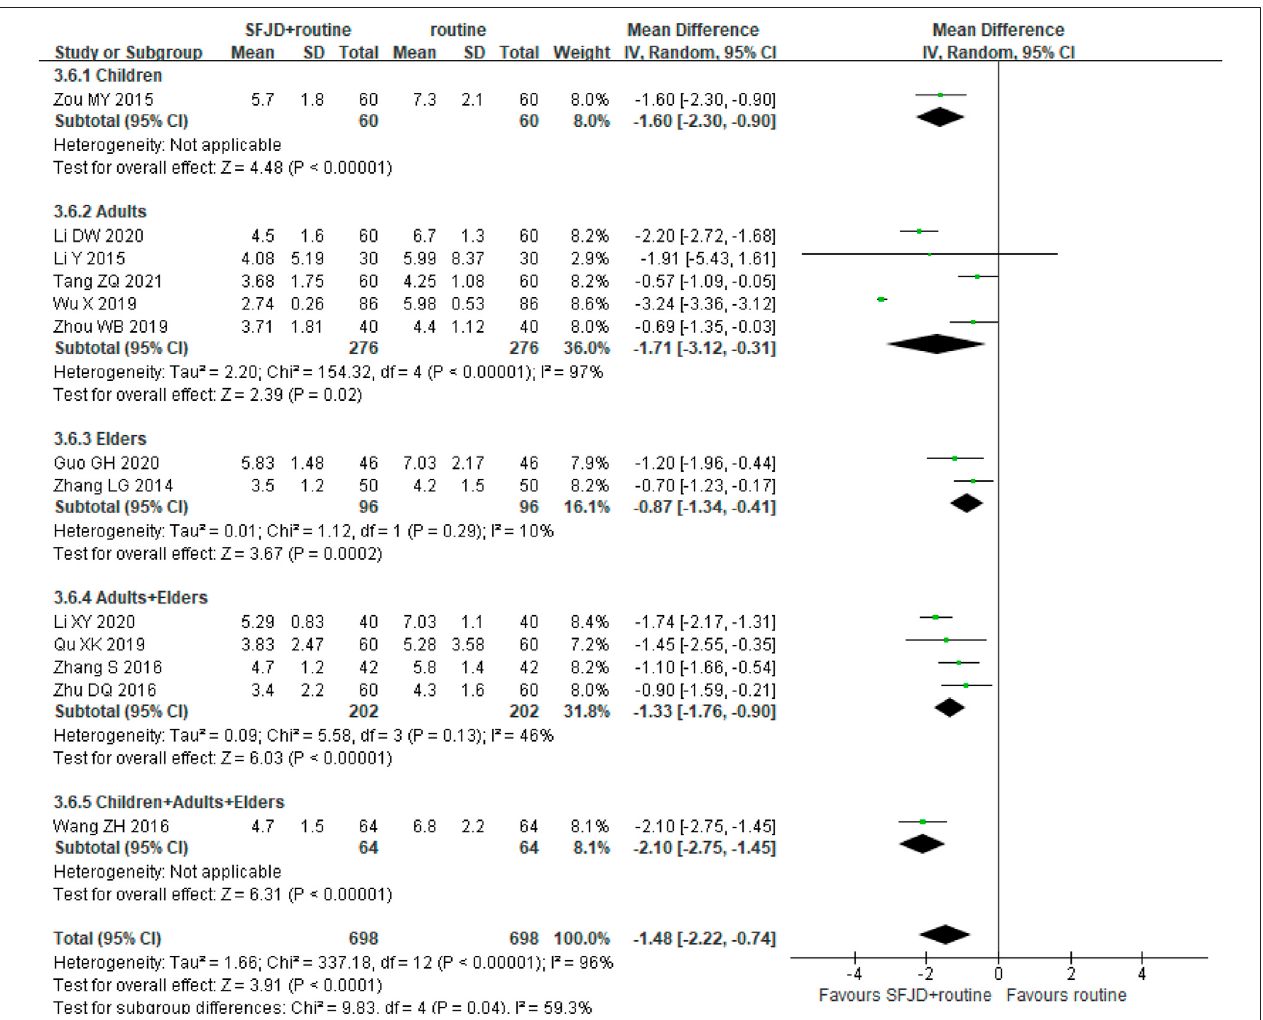
FIGURE 5 | Forest plot of duration of pulmonary crepitations (days) strati fi ed by age. Comparison: SFJD plus routine treatment vs. routine treatment. SFJD: Shufeng Jiedu.